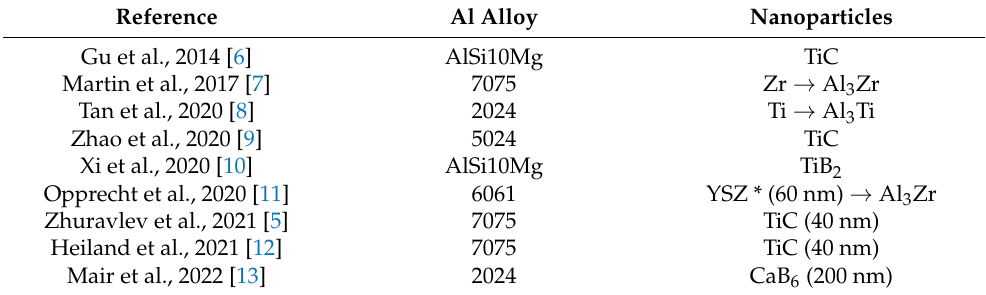
Table 1. Overview of several successful investigations regarding used aluminium alloys and nanoparticles. Reference Al Alloy